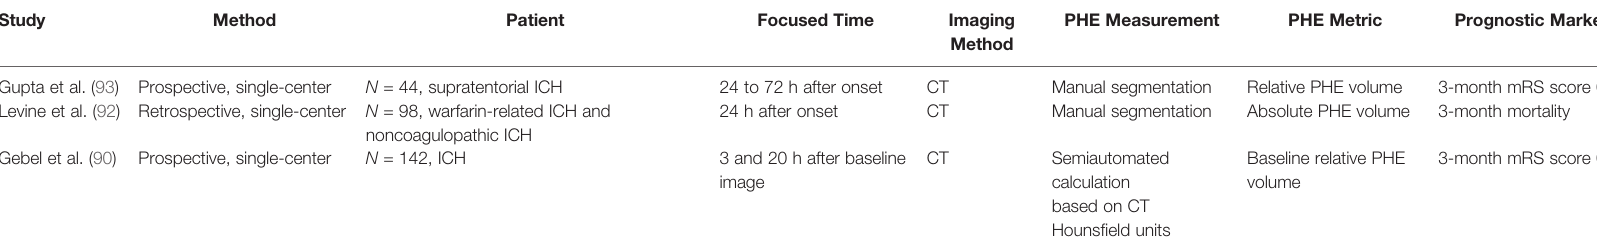
TABLE 2 | Summary of prognostic research of PHE — the PHE was associated with improved ICH outcome.